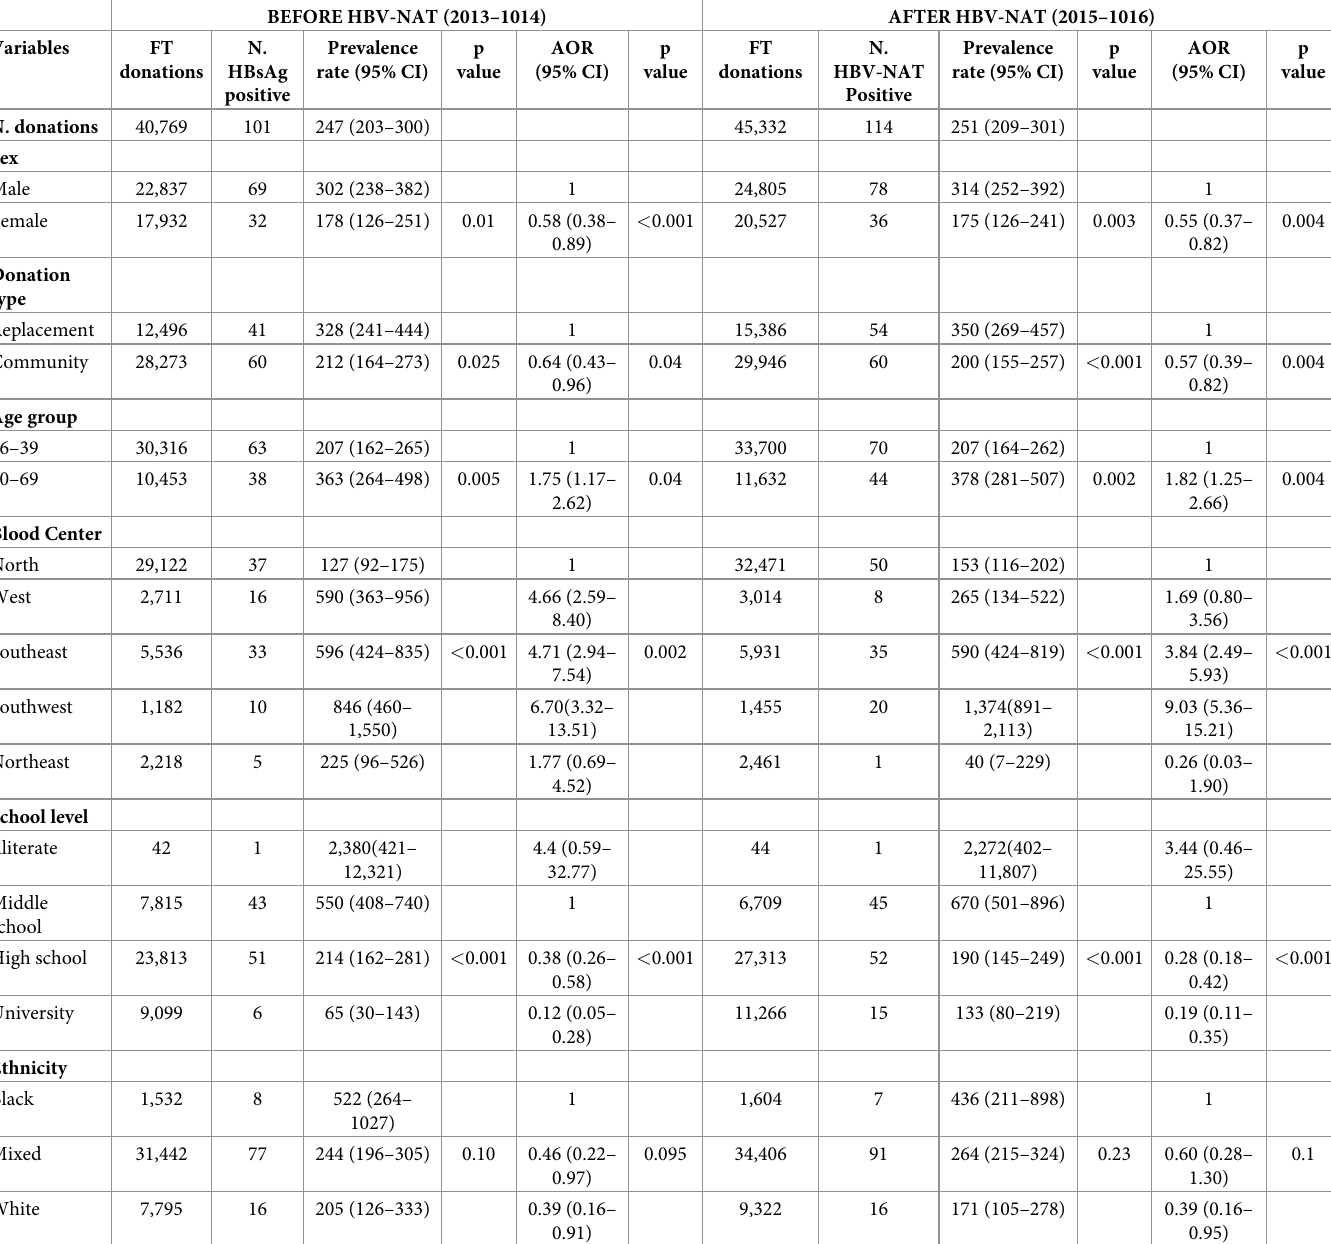
Table 2. Prevalence rate of HBV infection per 100,000 donations in Para´ state of Brazil, before and after HBV-NAT